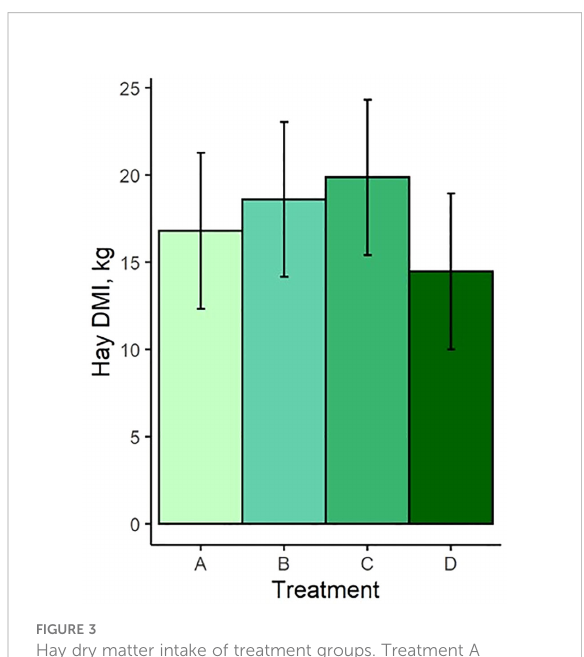
FIGURE 3 Hay dry matter intake of treatment groups. Treatment A contained 0.00% tea saponin (TS), B contained 0.16% TS, C contained 0.32% TS, and D contained 0.64%